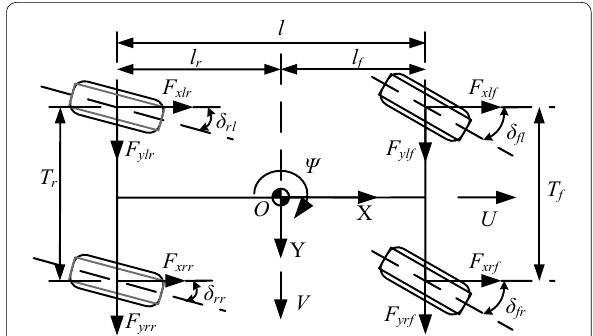
Figure 1 Vehicle dynamic